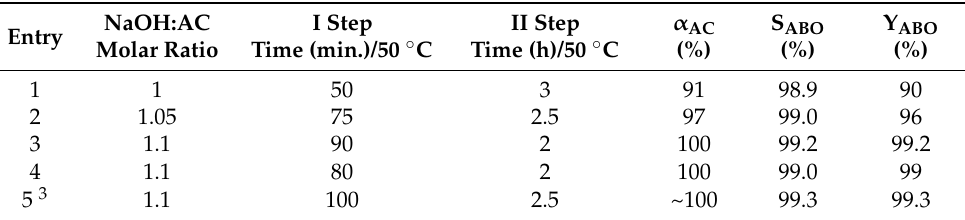
Table 2. The solvent-free mono- O -allylation of butane-1,4-diol by allyl chloride to 4-allyloxybutan-1-ol (ABO) in the presence of solid NaOH under non-catalytic conditions 1